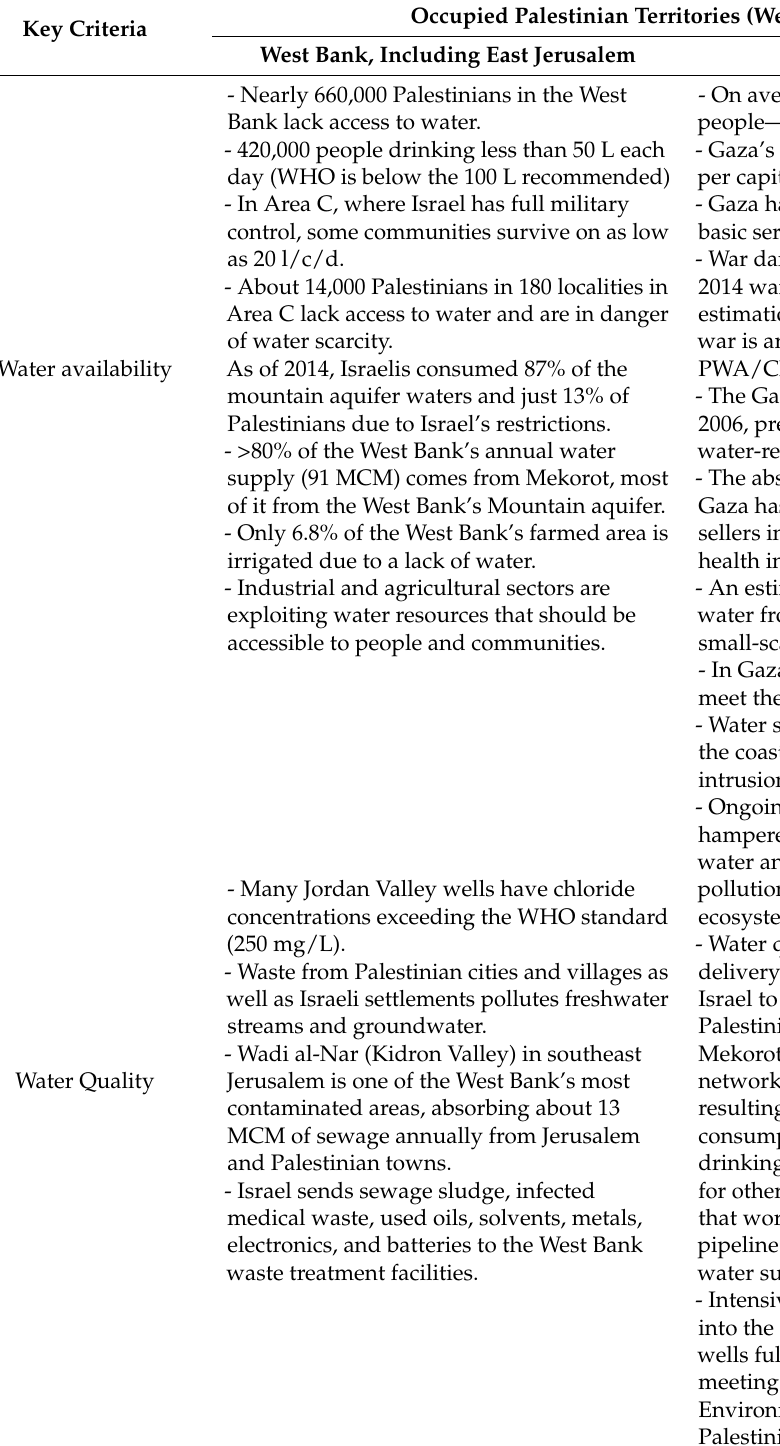
Table 2. Summary of allocation of water resources in OPT, including East Jerusalem table created by authors using various data sources mainly from UNHCHR [47]. The allocation of water resources in the Occupied Palestinian Territory, including East Jerusalem. Report of the United